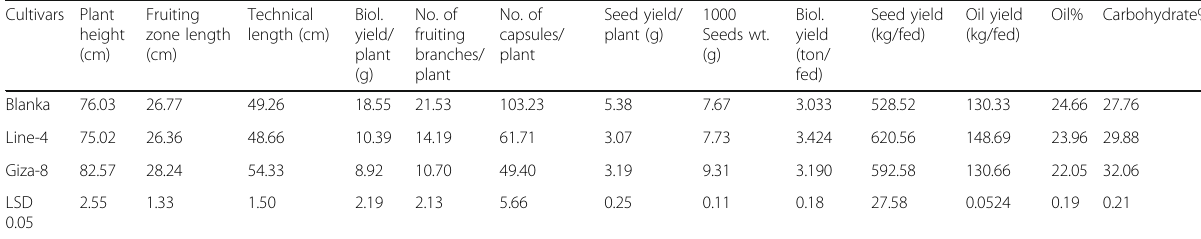
Table 4 Effect of cultivars on seed yield, its components, and oil and carbohydrate percentages of flax plants grown under sandy soil conditions (data are means of two successive seasons) Cultivars Plant height